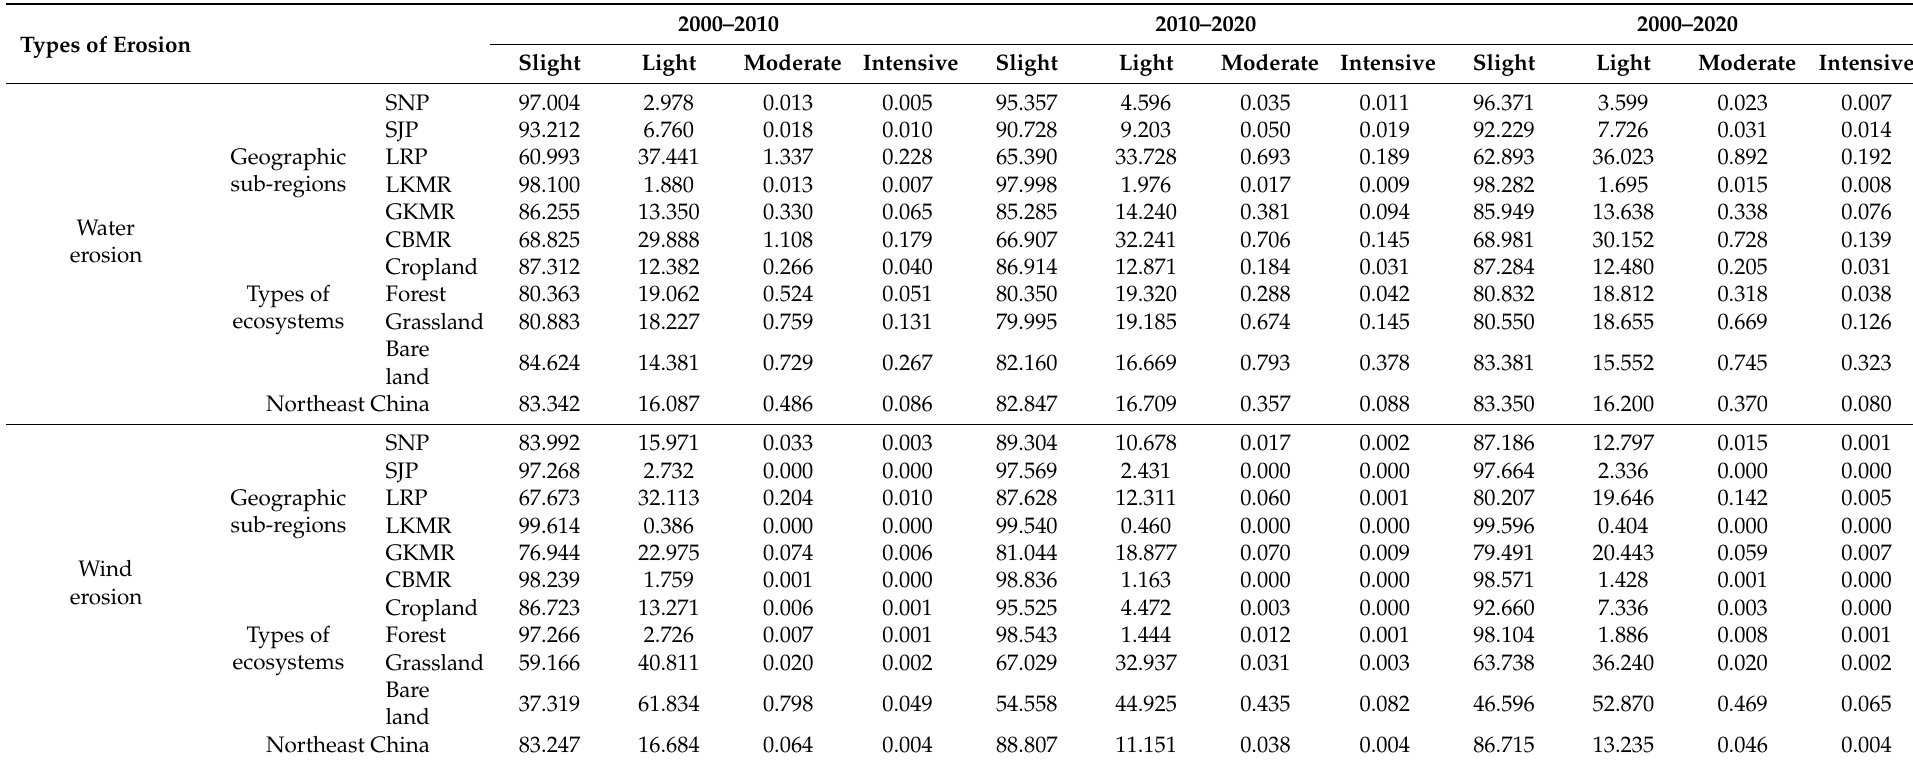
Table 3. Area percentage (%) of different degrees of water and wind erosion in Northeast China, displayed in different timespans. Types of